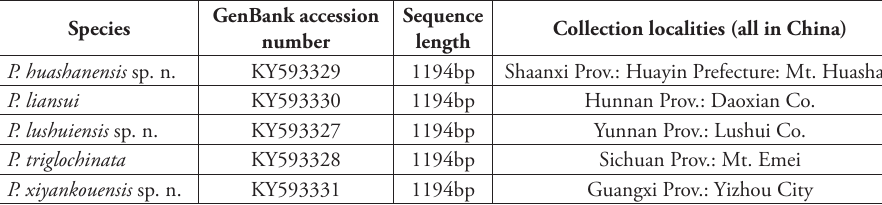
Table 1. Voucher specimen